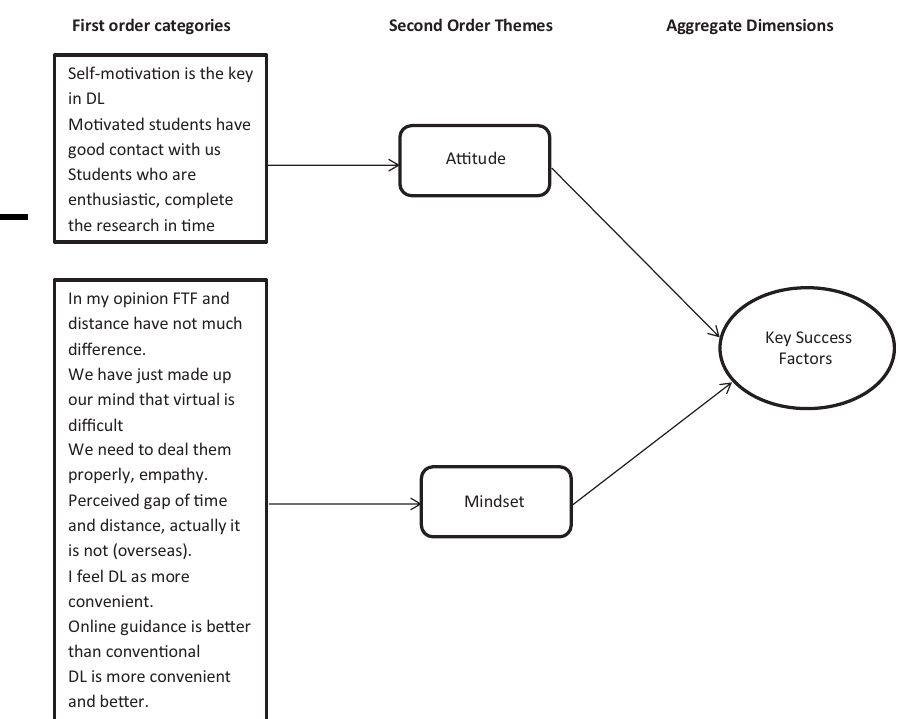
Figure 3. Key success